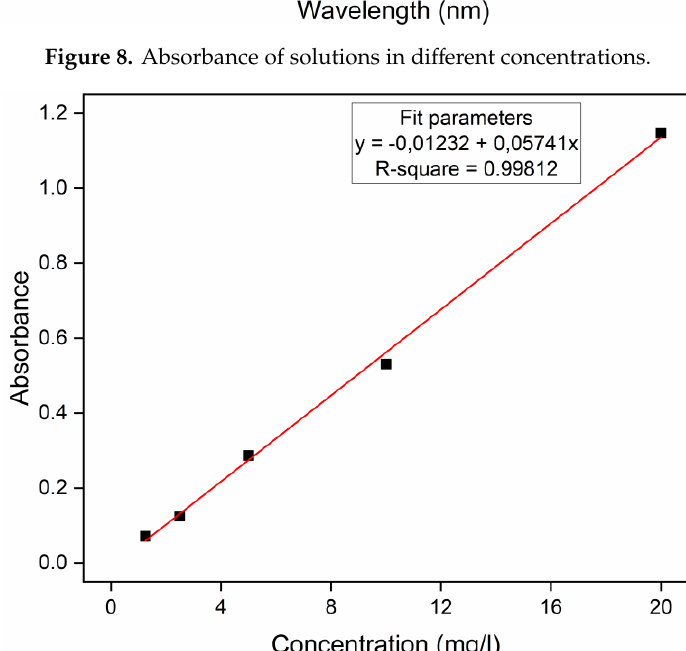
Figure 9 . Calibration curve of absorbance versus concentration. Figure 9. Calibration curve of absorbance versus